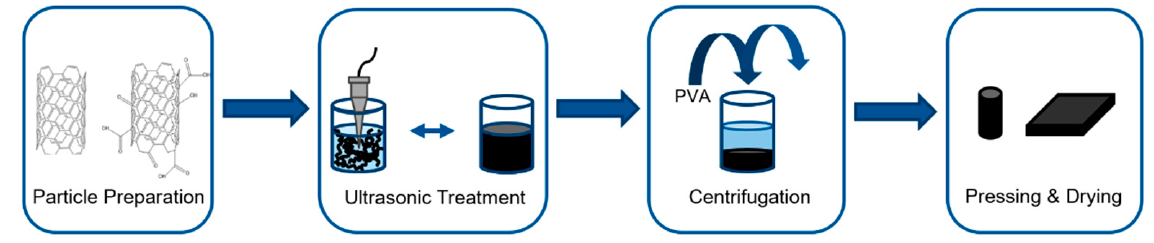
Figure 1. Schematic for the preparation of CNT monoliths.